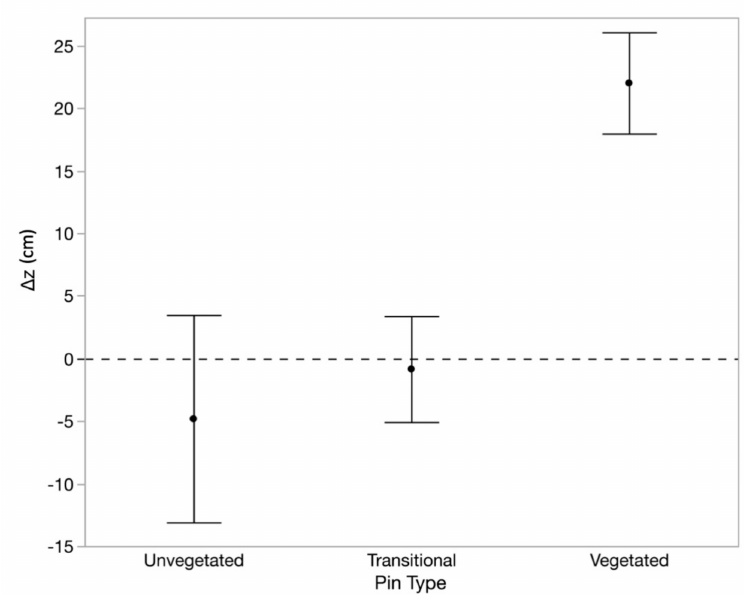
Figure 5. Total ∆ z , from the first collection with all three pin types to the final collection (collections 11 through 27, from October 2016 to September 2018). Despite less incremental ∆ z , erosional or accretional, season to season and during events throughout their installment, the vegetated pins accreted more than both the unvegetated and transitional pins. Error bars are standard error. Table 4. Vegetated pins consistently had less ∆ z (cm), regardless of collection type, but greater ∆ z increase over the duration of the install (Total ∆ z ) of all three pin types, collection 11 to 27. Differences between ∆ z and | ∆ z | highlight the importance of performing analyses on | ∆ z | given that instances of both positive and negative values in ∆ z otherwise obscure the results. Units are cm and means are presented with standard error.